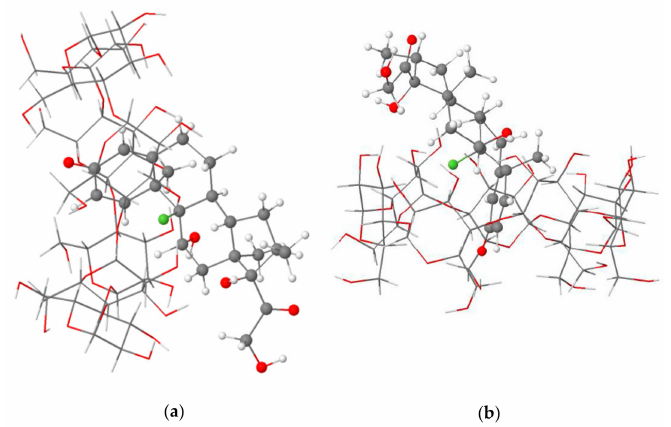
Figure 1. Side ( a ) and top ( b ) views of the partial inclusion of dexamethasone in the β -CD cavity as calculated at the BLYP-D4/def2-TZVP level of theory in the gas